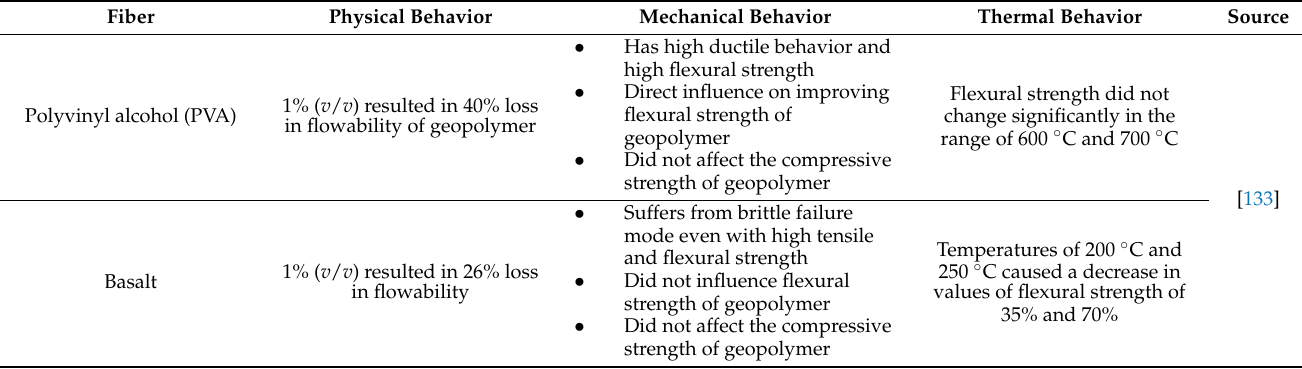
Table 4. Physical, mechanical, and thermal behaviors of PVA and basalt